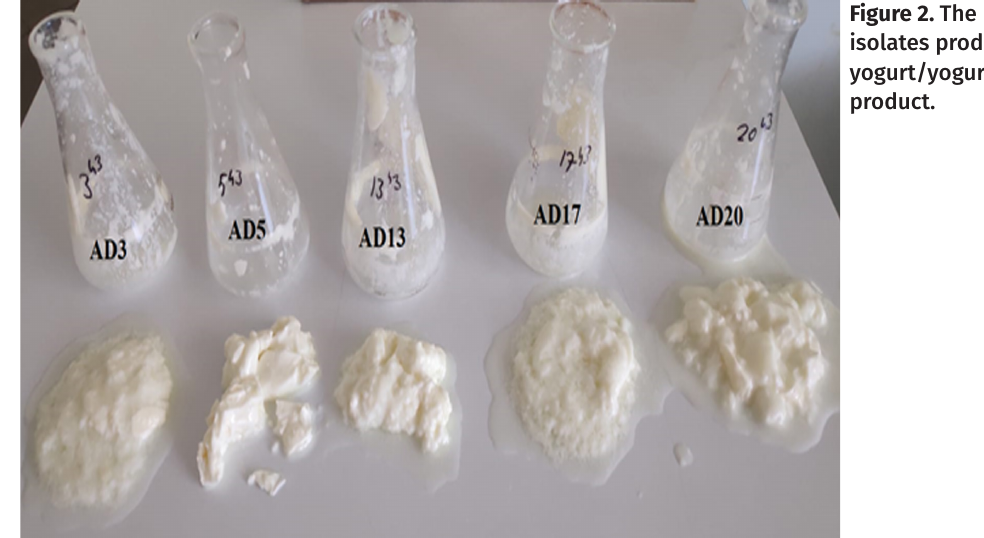
Figure 2. The bacterial isolates producing yogurt/yogurt-like